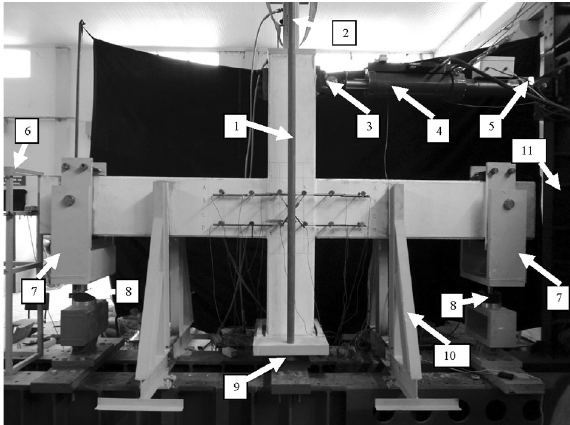
Fig. 10 Components in experimental set-up: ( 1 ) axial load frame, ( 2 ) hydraulic jack, ( 3 ) hinge, ( 4 ) actuator, ( 5 ) load cell, ( 6 ) reference frame, ( 7 ) pendulum support, ( 8 ) load cell, ( 9 ) fixed support, ( 10 ) out-of-plane support frame, ( 11 ) steel reaction frame.